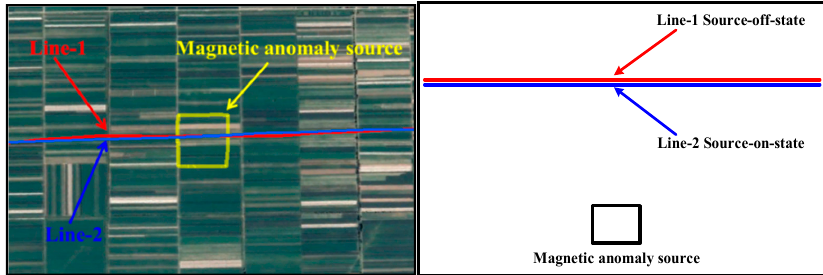
Figure 11. The flight path in Google Earth and its scale drawing.